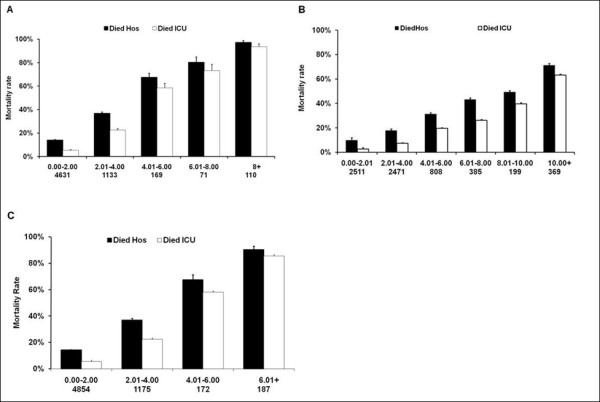
Relationship among the admission, maximal and time weighted blood lactate concentration and mortality. Relationship among the admission blood lactate concentration (LacADM) Panel (a); maximal blood lactate concentration (LacMAX;) Panel (b); and time weighted blood lactate concentration (LacTW) Panel (c); and hospital and ICU mortality. The number of patients in each group is expressed as (n).